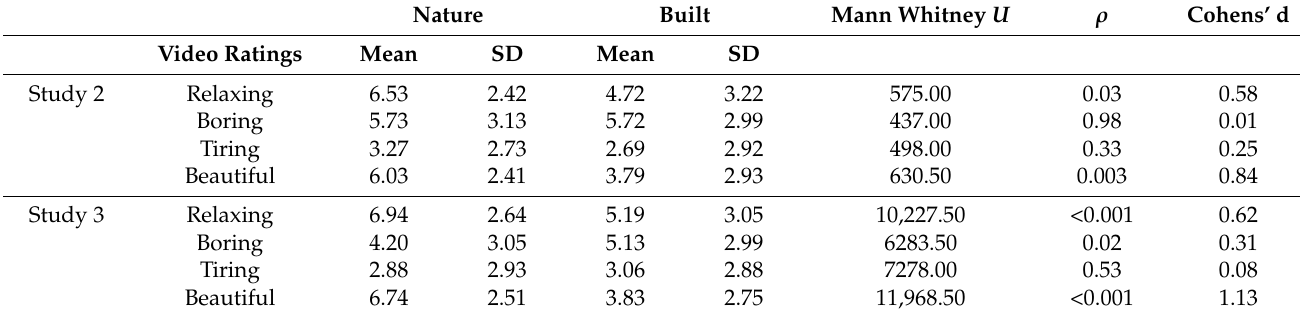
Table A1. Descriptive and Outcome Statistics for the Environmental Video Checks.